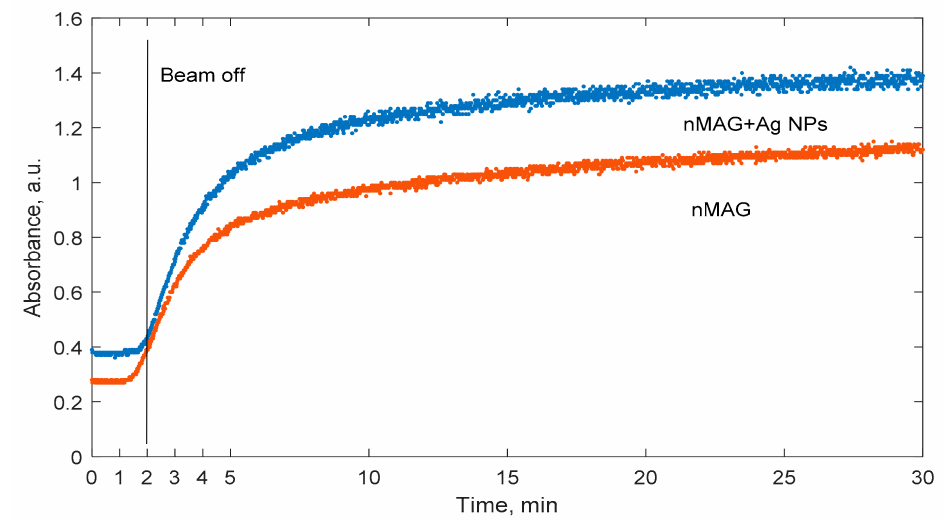
Figure 4. Temporal variations of optical properties of irradiated nMAG gels composed with and without Ag